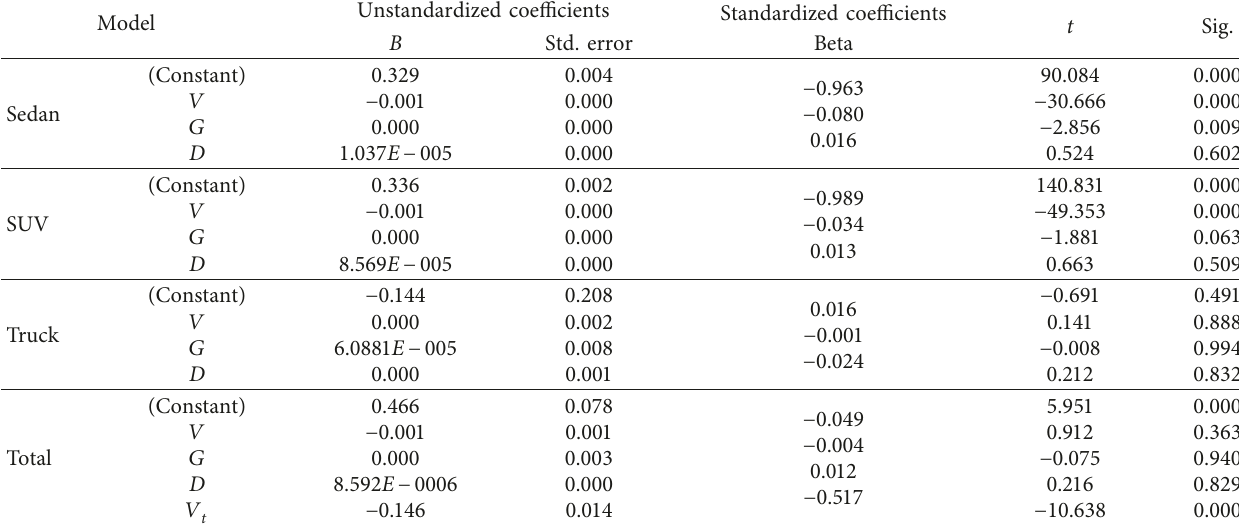
Table 4: Model coefficients for the lateral acceleration of the design’s